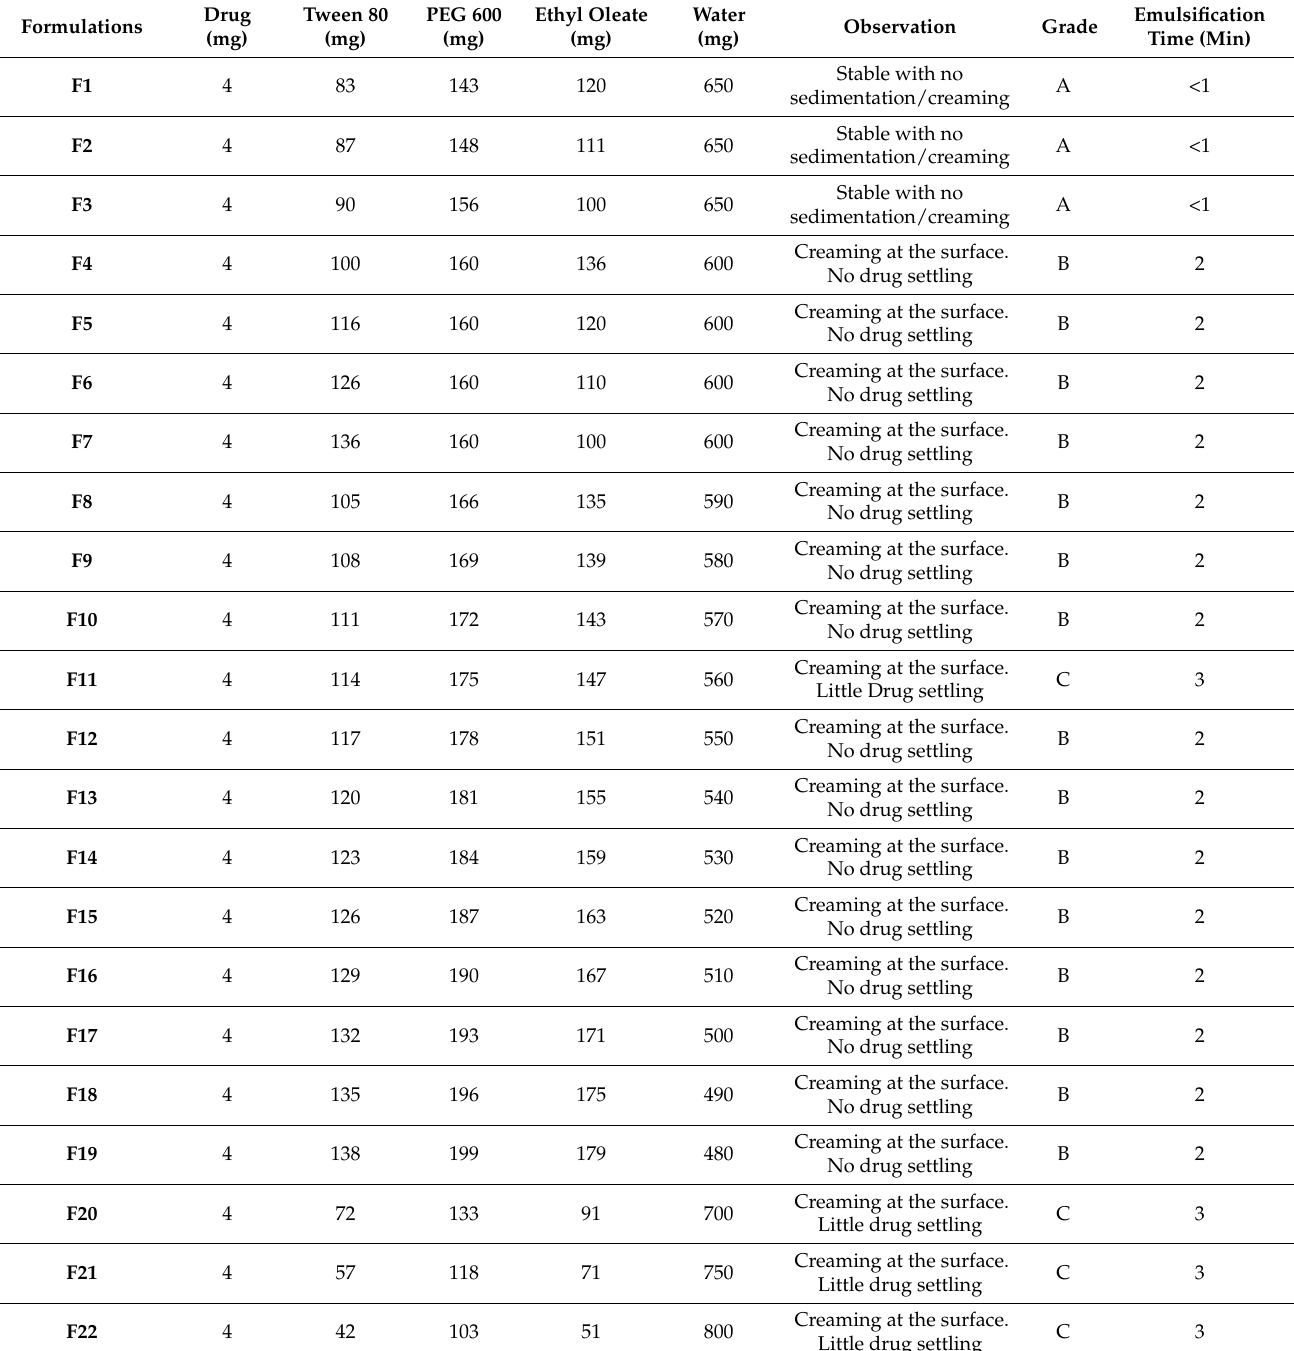
Table 1. The results of formulation optimization of curcumin-loaded